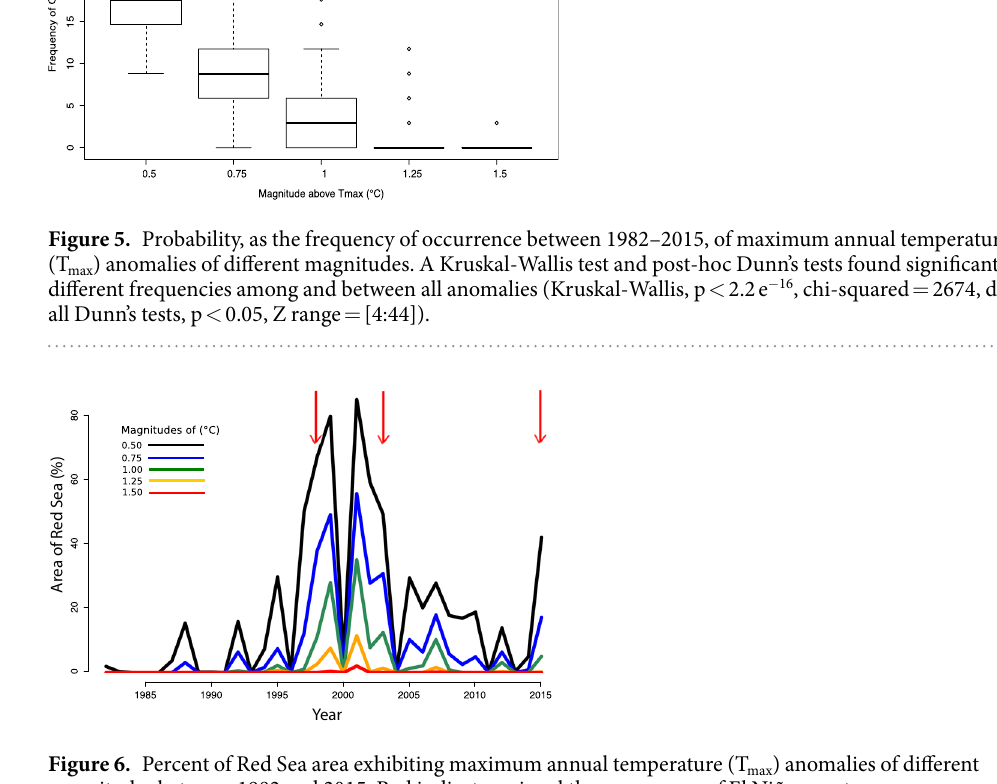
effect of temperature on grazing rates of Red Sea parrotfish 38 , there is, at present, no quantitative information on the thermal limits of Red Sea biota. However, reports of a decline in coral growth and calcification across the thermal range of Red Sea corals 39 , together with widespread bleaching in the southern half of the Red Sea during 2015, as well as lower growth rates reported for brown macroalgae 40 , suggests that warm Red Sea temperatures already challenge the capacities of organisms. In addition to increasing T max , the general tendency towards an earlier occurrence indi- cates that phenology patterns of organisms might need to adjust to this shift. Marine organisms generally cope with